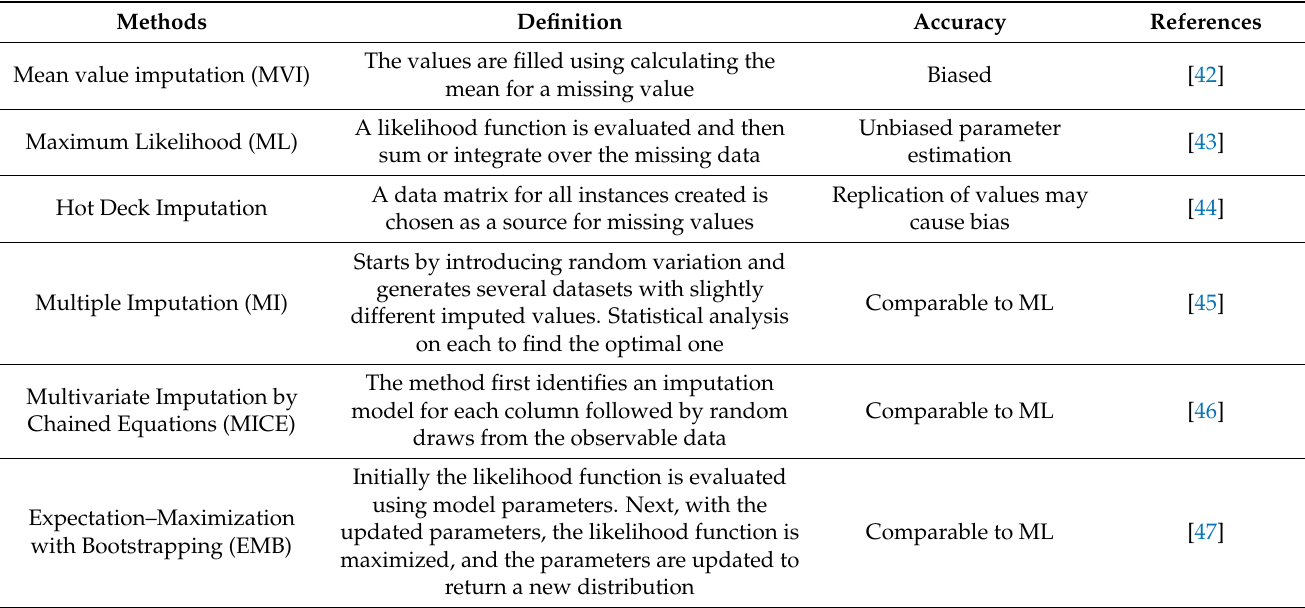
Table 1. Data imputation